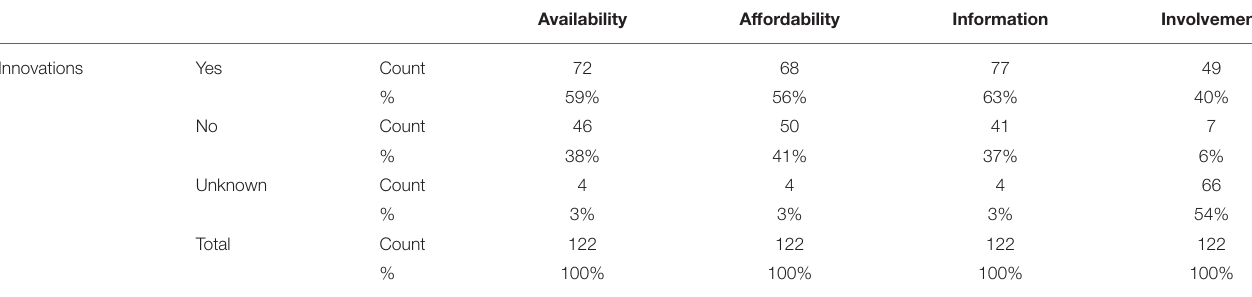
TABLE 5 | The extent to which innovations demonstrate four indicators of energy justice ( n = 488). Availability Affordability Information Involvement